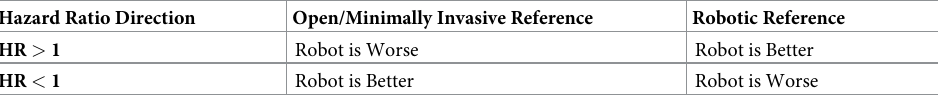
Table 1. Determination of reference group for hazard ratio: Table to assist extractors in identifying reference group, determining need to invert hazard ratios. Hazard Ratio Direction Open/Minimally Invasive Reference Robotic Reference HR > 1 Robot is Worse Robot is Better HR < 1 Robot is Better Robot is